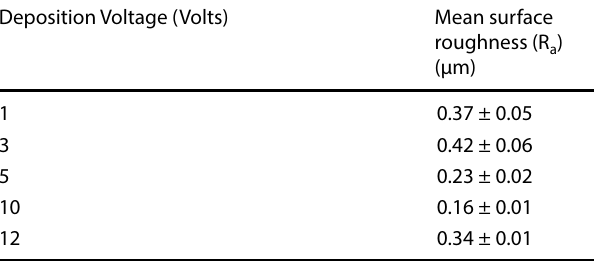
Table 1 Surface roughness of the graphene oxide coated 304SS Deposition Voltage